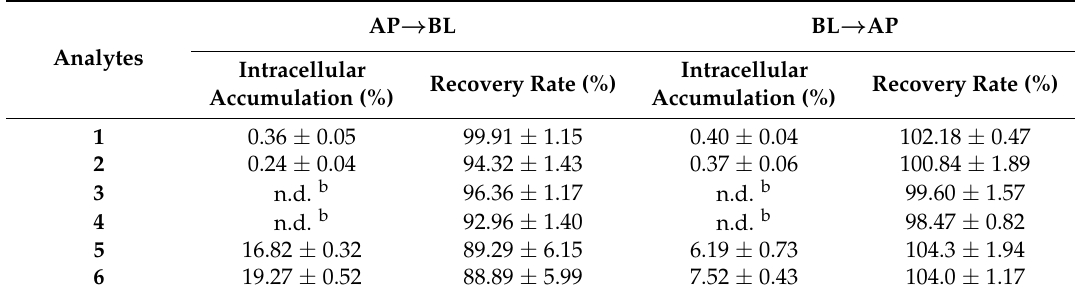
Table 5. The bidirectional intracellular accumulation rates and total recovery rates in transport of 1 – 6 on the MDCK-pHaMDR cell monolayer. a